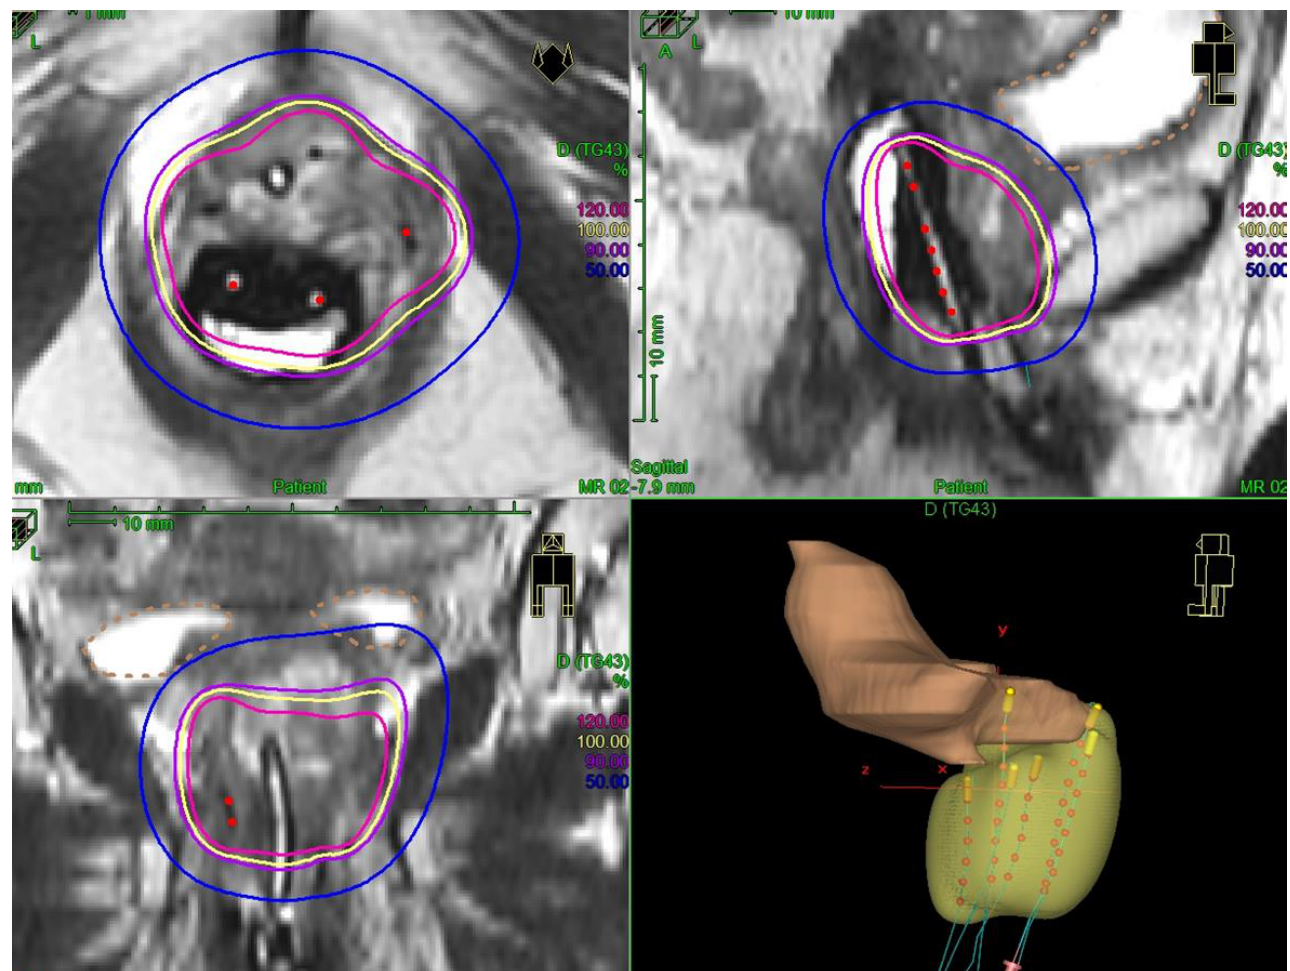
Figure 1. Example of image-guided pulse-dose-rate treatment for a primary para-urethral carcinoma. Patient was treated with pulse-dose-rate brachytherapy boost, delivering 15 Gy in pulse-dose-rate brachytherapy. In yellow is shown the 100% isodose. A vaginal mold applicator with anterior catheters was used and three interstitial needles were implanted to encompass the urethra.